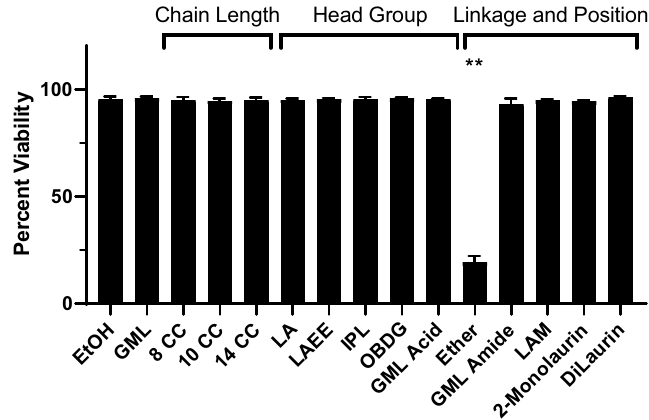
Figure 2. Cell viability assay. Rested Human APBTs were treated with 10ug/mL of designated compound overnight and tested for viability via Trypan Blue exclusion. Data presented is an average percentage of viable cells calculated using (Trypan Blue Positive Cells)/(Trypan Blue Pos. + Trypan Blue Neg.) compiled from 3 independent experiments. Statistical significance was determined using a Repeated Measures One-Way ANOVA with Dunnett’s multiple comparison’s test. (* p < 0.05, ** p < 0.01, *** p <